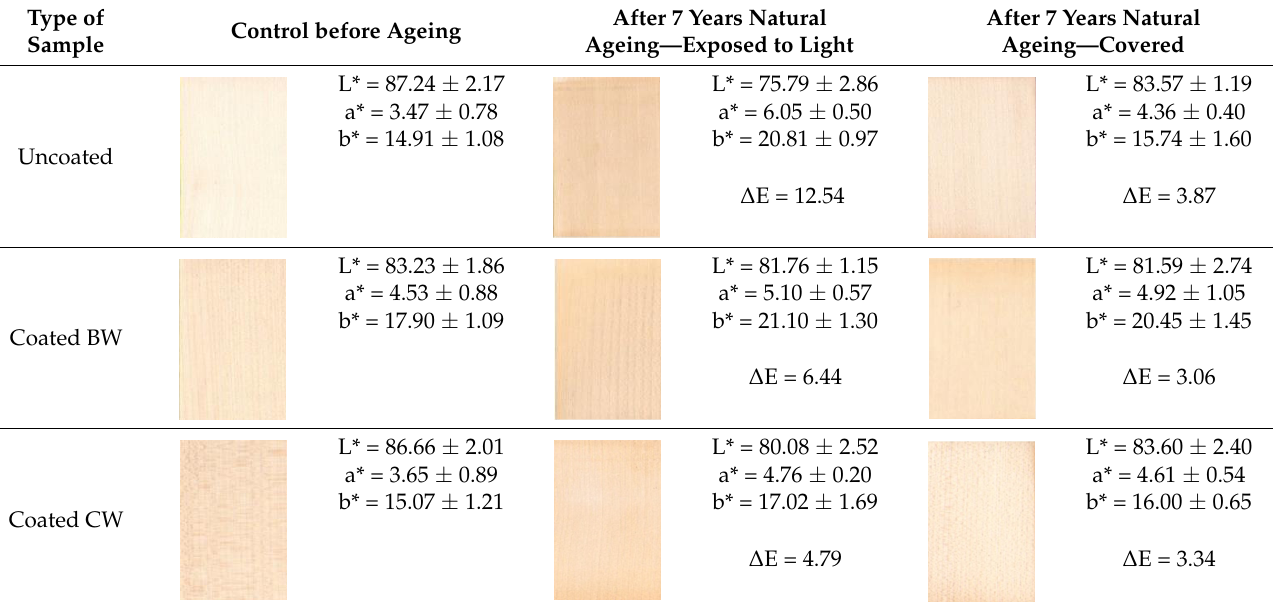
Table 1. Visual assessment and colour measurements of European maple wood ( Acer pseudoplatanus ) before and after natural ageing.